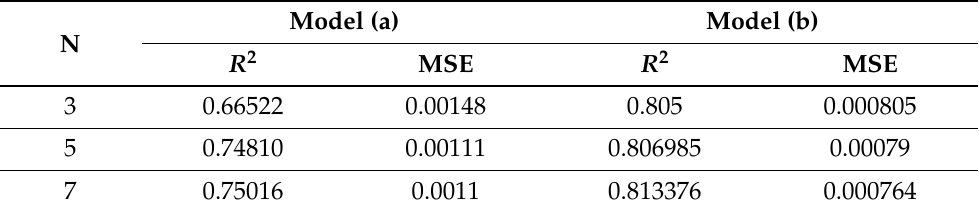
Table 3. Results of the prediction performance with different values of N